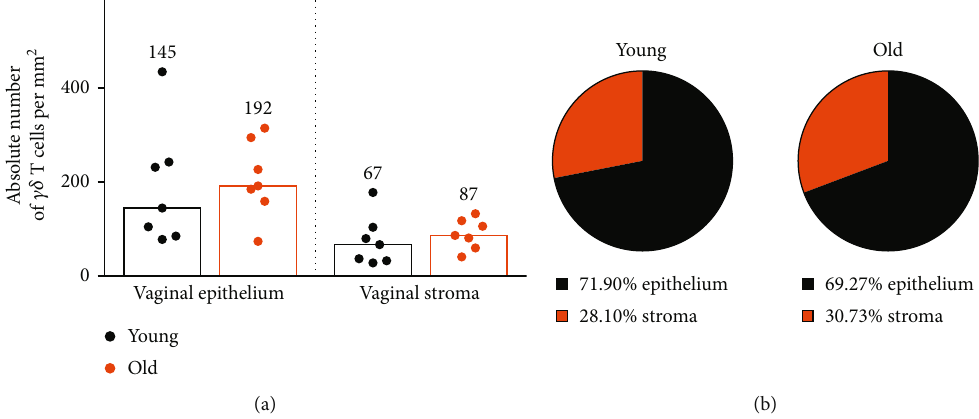
Figure 2: Analysis of γδ T cell distribution in vaginal compartments in young and old mice. (a) Absolute number of γδ T cells in vaginal epithelium and stroma based on microscopic image analysis. Each spot represents an individual young mouse (black, 2 months old) or old mouse (orange, 18 months old). N = 7 mice per group. Bars and numbers show medians. No statistically signi fi cant di ff erences between groups (Mann – Whitney U test). (b) The percentage distribution of γδ T cells in vaginal compartments in young and old